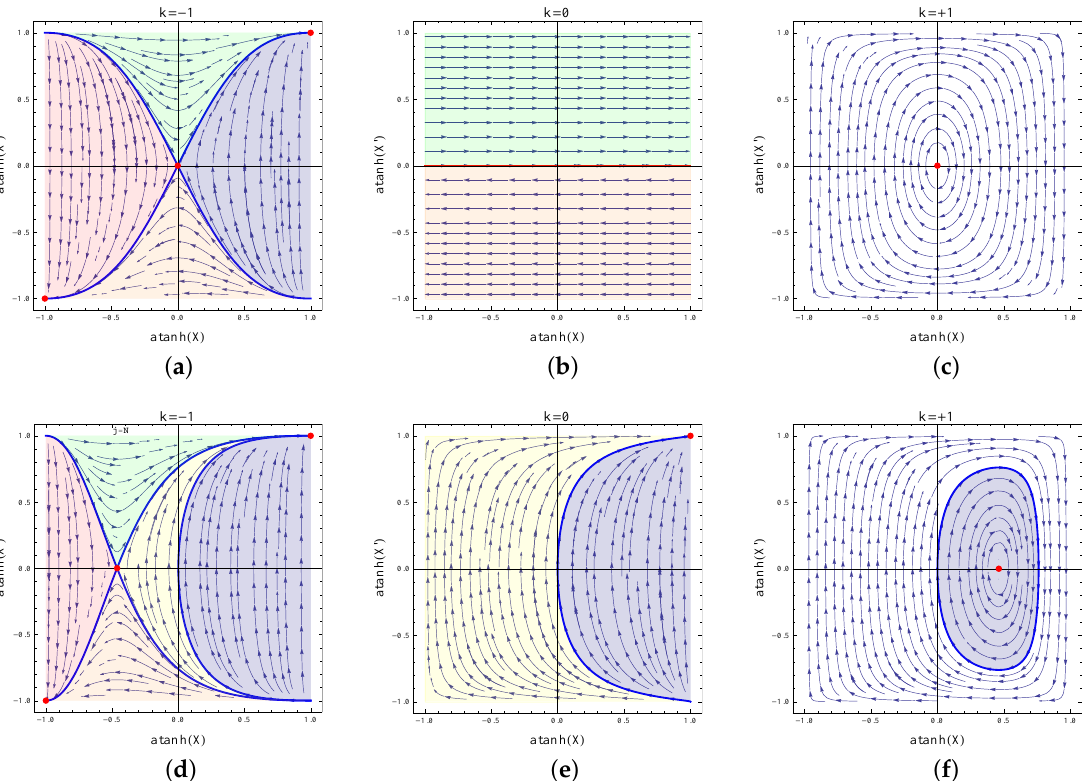
Figure 2. Behaviour of X and X (cid:48) for a scalar-tensor theory without potential. The upper three phase diagrams, ( a – c ), respectively, correspond to the k = − 1,0, + 1 cases for vacuum and stiff fluid. The lower three phase diagrams, ( d – f ), respectively, correspond to the k = − 1,0, + 1 cases for